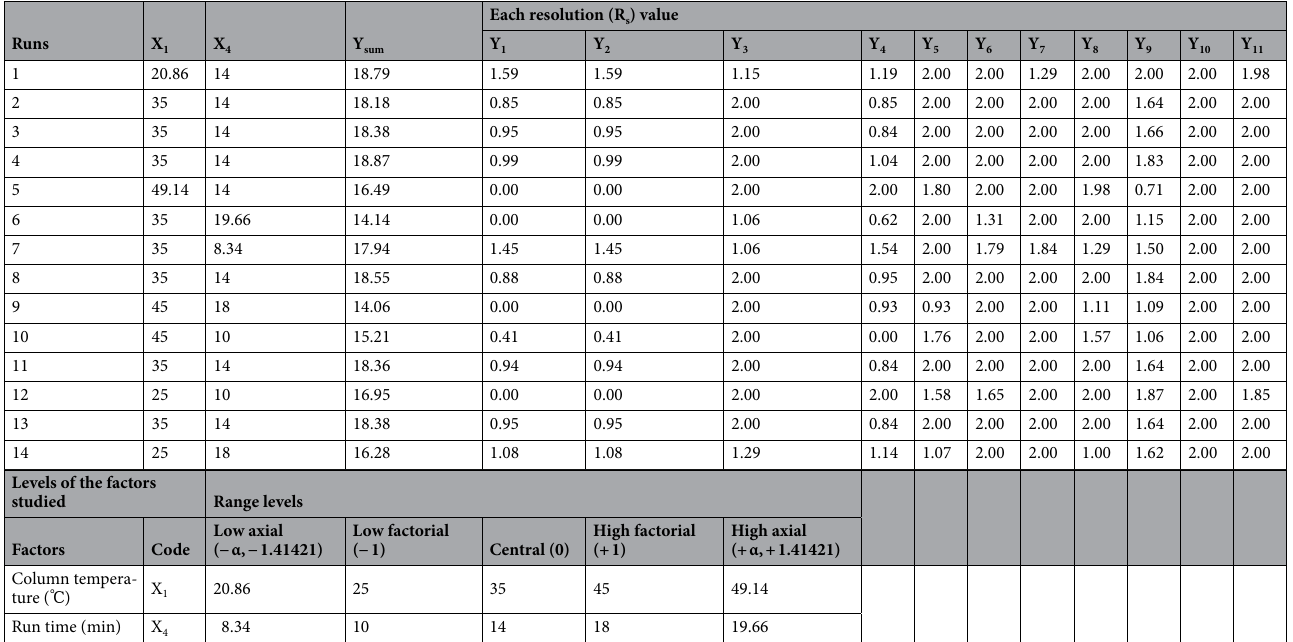
Table 5. Central composite design (CCD) matrix for response surface and the studied responses. Y sum summarizes the eleven